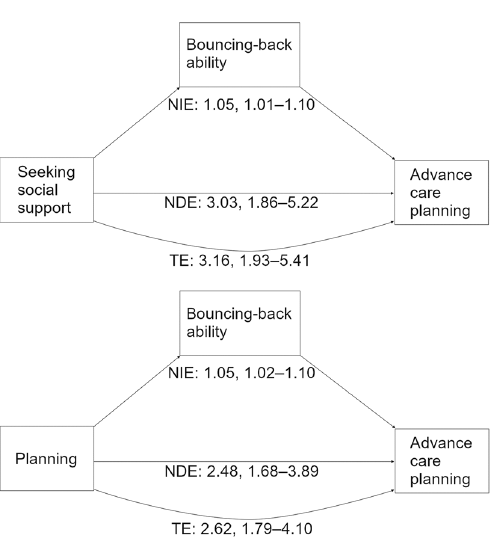
Figure 1. Odds ratios for the occurrence of advance care planning discussions by type of stress coping. ( a–d ) The results of the multivariable logistic regression models (Models 2–5), respectively. In each model, stress coping (seeking social support, planning, avoidance, and alcohol and drug use) was used as the main exposure variables, with “advance care planning discussions during the COVID-19 pandemic” as the outcome variable. All models were adjusted for age, sex, marital status, education level, annual income, comorbidities, caregiving experience, religious beliefs, COVID-19 literacy, media exposure about COVID-19, stress and anxiety in relation to COVID-19, COVID-19 vaccination status, and COVID-19 incidence as covariates.